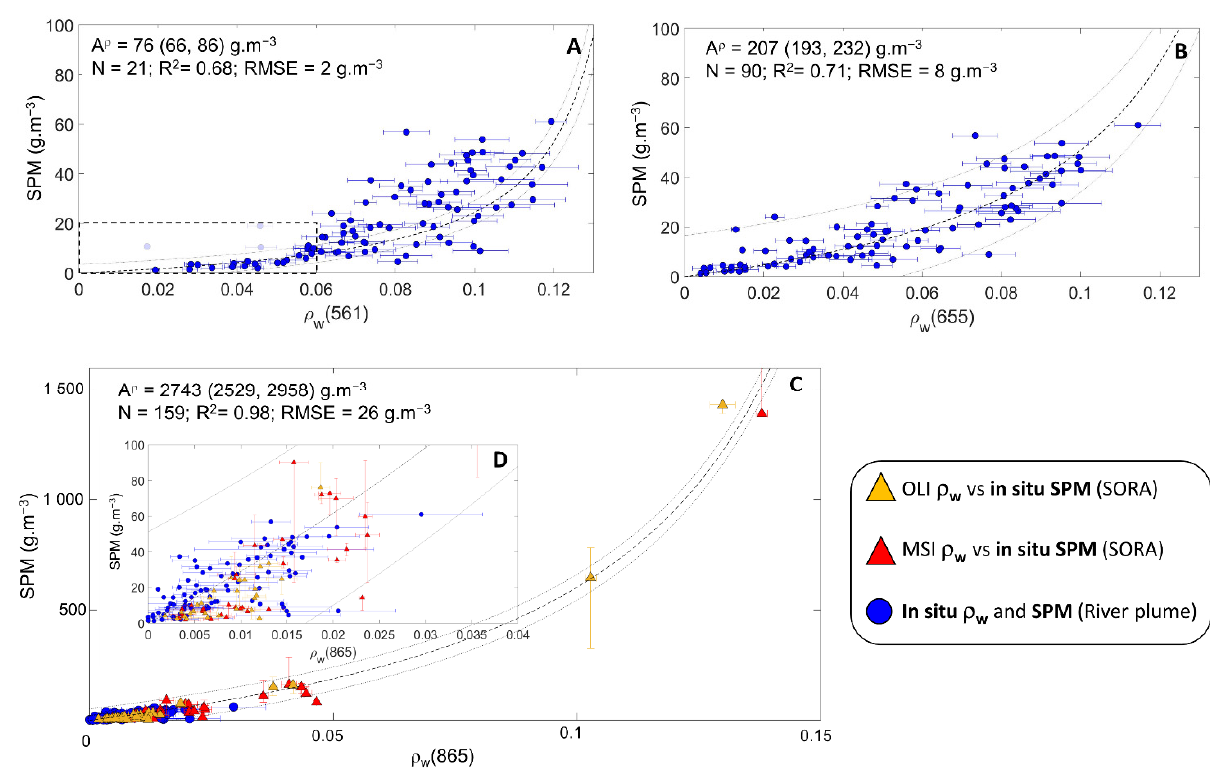
Figure 3. Nechad ρ w vs. SPM relationships obtained for the 555 nm ( A ), 665 nm ( B ), and 865 nm ( C , D ) spectral bands of the OLI sensor. ( D ) Zoom on the 865 nm relationship for SPM concentrations lower than 100 g.m − 3 . The fitted Nechad coefficient A ρ (g.m − 3 ) (and C ρ for the NIR band) as well as its 95% confidence bounds are indicated on the plots and reported in Table 2 with parameter values for other sensors. N is the number of data fitted for each relationship. For the green band, the A ρ coefficient was calibrated using ρ w values lower than 0.06 only (dark dotted squares) and three outlier measurements were removed (light blue points). Error bars for in situ data from field campaigns correspond to the standard deviation computed on averaged ρ w data. Error bars on SPM measured at SORA station correspond to the maximum SPM concentration variations observed at ± 1 day. Error bars on OLI- and MSI-derived ρ w data correspond to the standard deviations computed within the 3 × 3 pixels box centered on the SORA station.